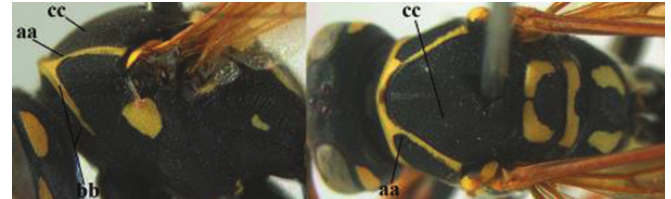
spots (cc); [colour pattern is highly variable in this species, more so than in Europe]; Europe and Palaearctic Asia ................... P. nimpha (Christ, 1791)